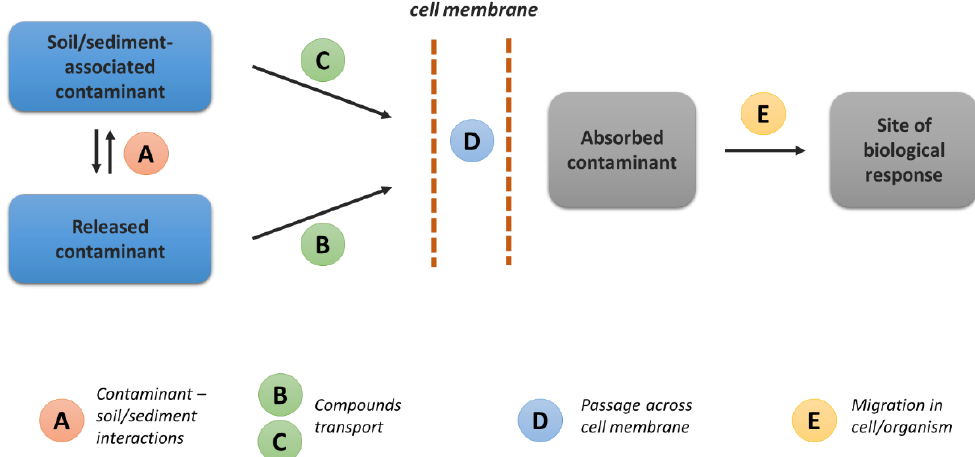
Figure 1. Bioavailability of organic chemicals according to Ortega-Calvo et al. [13]. Adapted with permission from Ref. [13]. Copyright 2013, American Chemical Society.